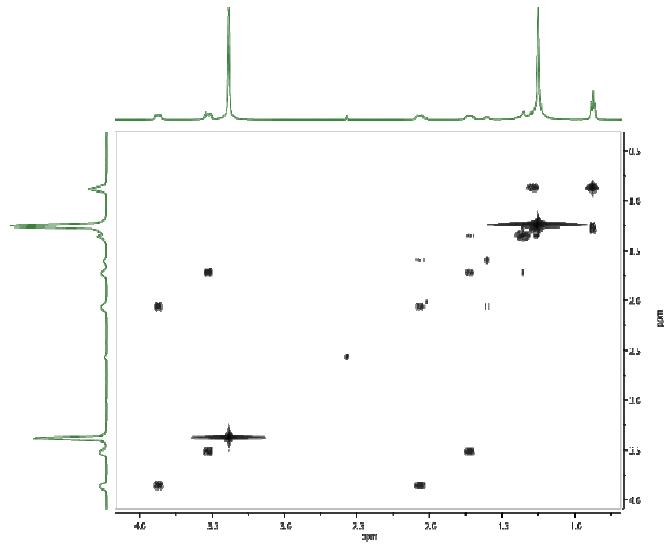
6. COSY NMR spectrum for hexamethylene-1,6-bis( N,N -dimethyl- N - dodecyldodecylammonium bromide) ( 1 ).